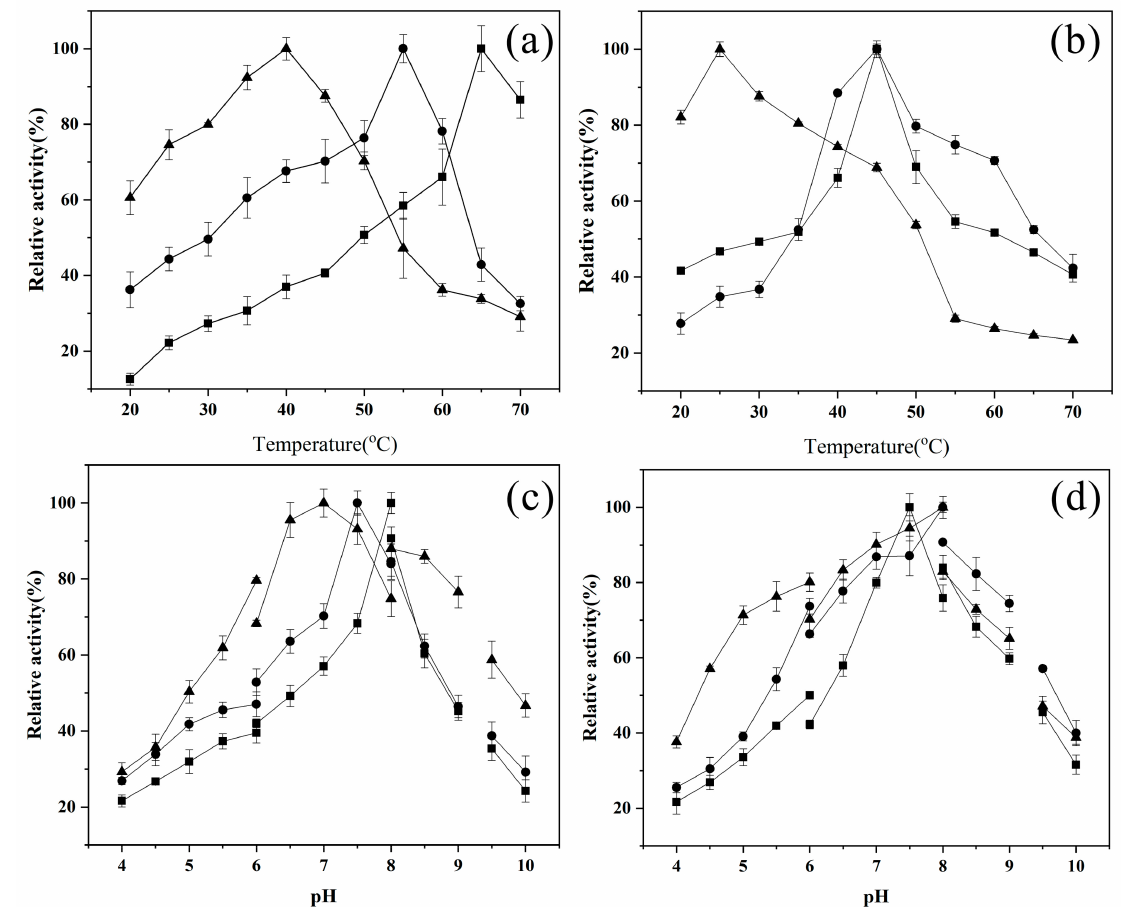
Figure 4. Biochemical characteristics of Mi Xen-CD ( (cid:4) ), Mi Xen-CBM84 ( • ) and Mi Xen-CBMx ( (cid:78) ) [14]. ( a ) The optimun reaction temperatures of the endotype xanthanases with xanthan as the substrate. ( b ) The thermostability of the endotype xanthanases. ( c ) The optimum reaction pHs of the endotype xanthanases with xanthan as the substrate. ( d )The pH stability of three endotype xanthanases. Buffers: HOAc-NaOAc buffer (pH 4.0 to 6.0), NaH 2 PO 4 -Na 2 HPO 4 buffer (pH 6.0 to 8.0), Tris-HCl buffer (pH 8.0–9.0), and NaHCO 3 -NaOH buffer (pH 9.5 to